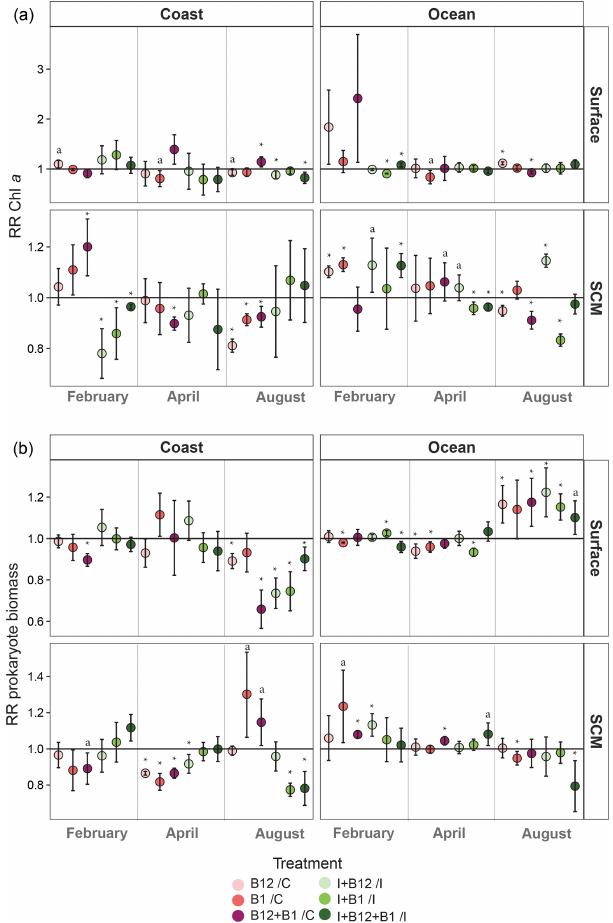
Figure 7. Monthly averaged response ratio (RR) of (a) Chl a or (b) prokaryote biomass at surface and SCM depth in the coastal and oceanic stations. The horizontal line represents a response equal to 1, which means no change relative to control in the pink dots (treatments with vitamins alone) and no change relative to inor- ganic (I) treatment in the green dots (vitamins combined with I treatments). Asterisks indicate averaged RRs that were significantly different from 1 ( Z test; ∗ p< 0 . 05), and “a” labels indicate averaged RRs that were marginally significant ( Z test; a p = 0 . 05–0.06). Er- ror bars represent standard error. SCM: subsurface chlorophyll max-